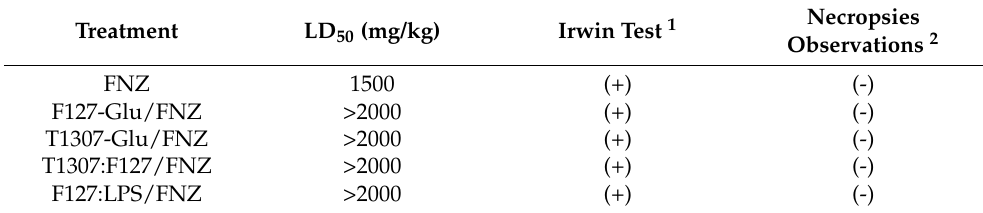
Table 3. In vivo acute toxicity via